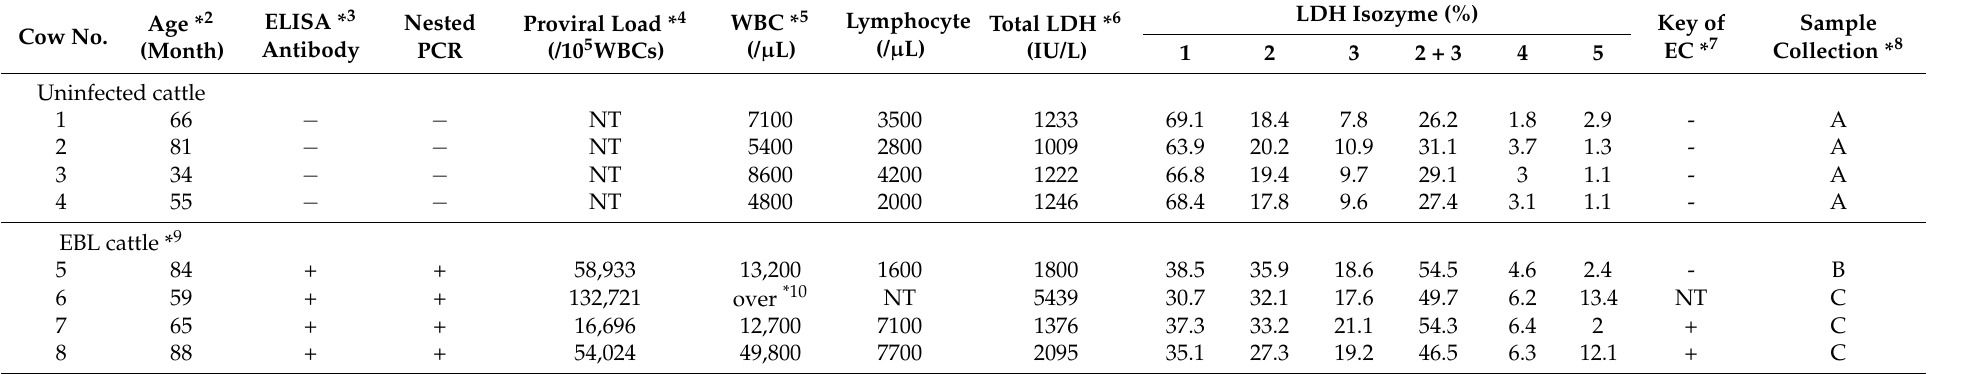
Table 1. BLV infection and clinical status of cattle used in microarray analysis * 1